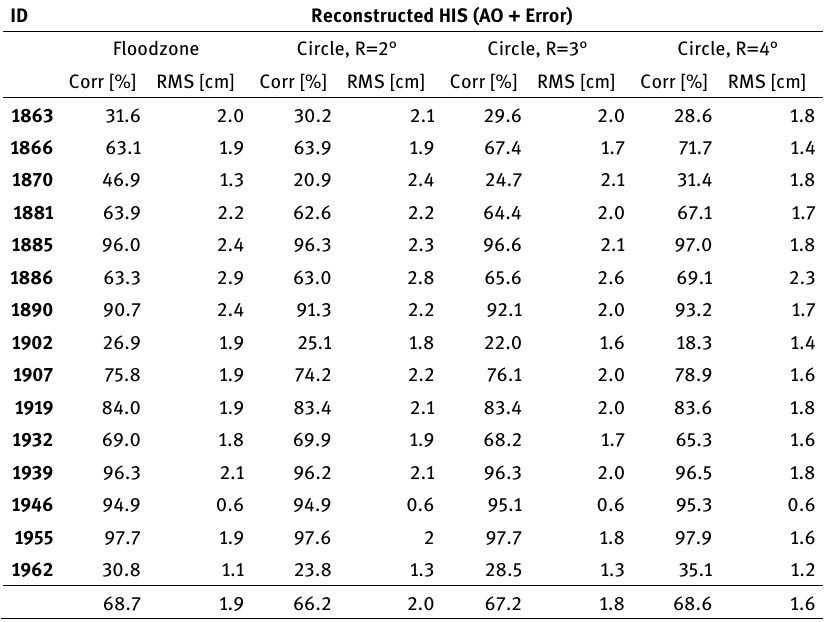
Table 6. Correlation [%] and RMS [cm] of reconstructed HIS signal to the original ESA ESM HIS for the 15 selected study cases (d/o 30).